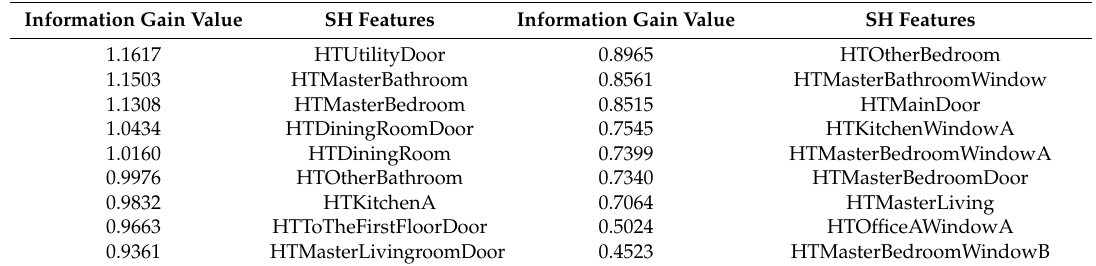
Table 18. InfoGain method predictions for indoor methanol in IAQ 1 .